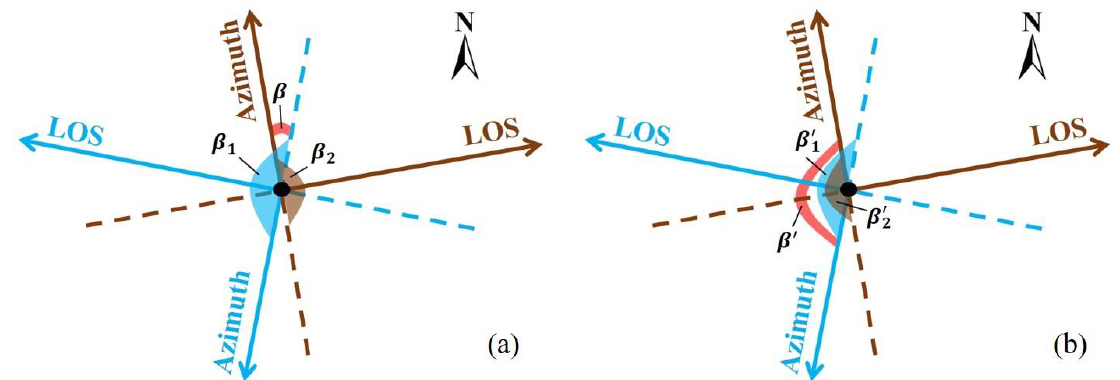
Figure 9. SAR imaging geometries of the ascending and descending satellites. ( a ) The deformation of a surface point was negative relative to two flight directions. ( b ) The deformation of a surface point was positive and negative relative to two flight directions. Blue and brown represent descending and ascending tracks, respectively. 𝛽 1 and 𝛽 1′ were the range of moving azimuth angle for the descending track. 𝛽 2 and 𝛽 2′ were the range of moving azimuth angle for the ascending track. 𝛽 and 𝛽 ′ were the intersections for the descending track and ascending track, respectively.